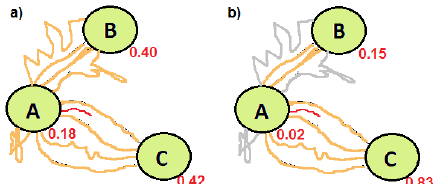
Figure 7: Example for the different results of the destination pre- diction of an object in the presence of bad tracks (red: current seg- ment, orange: considered segments, grey: neglected segments)